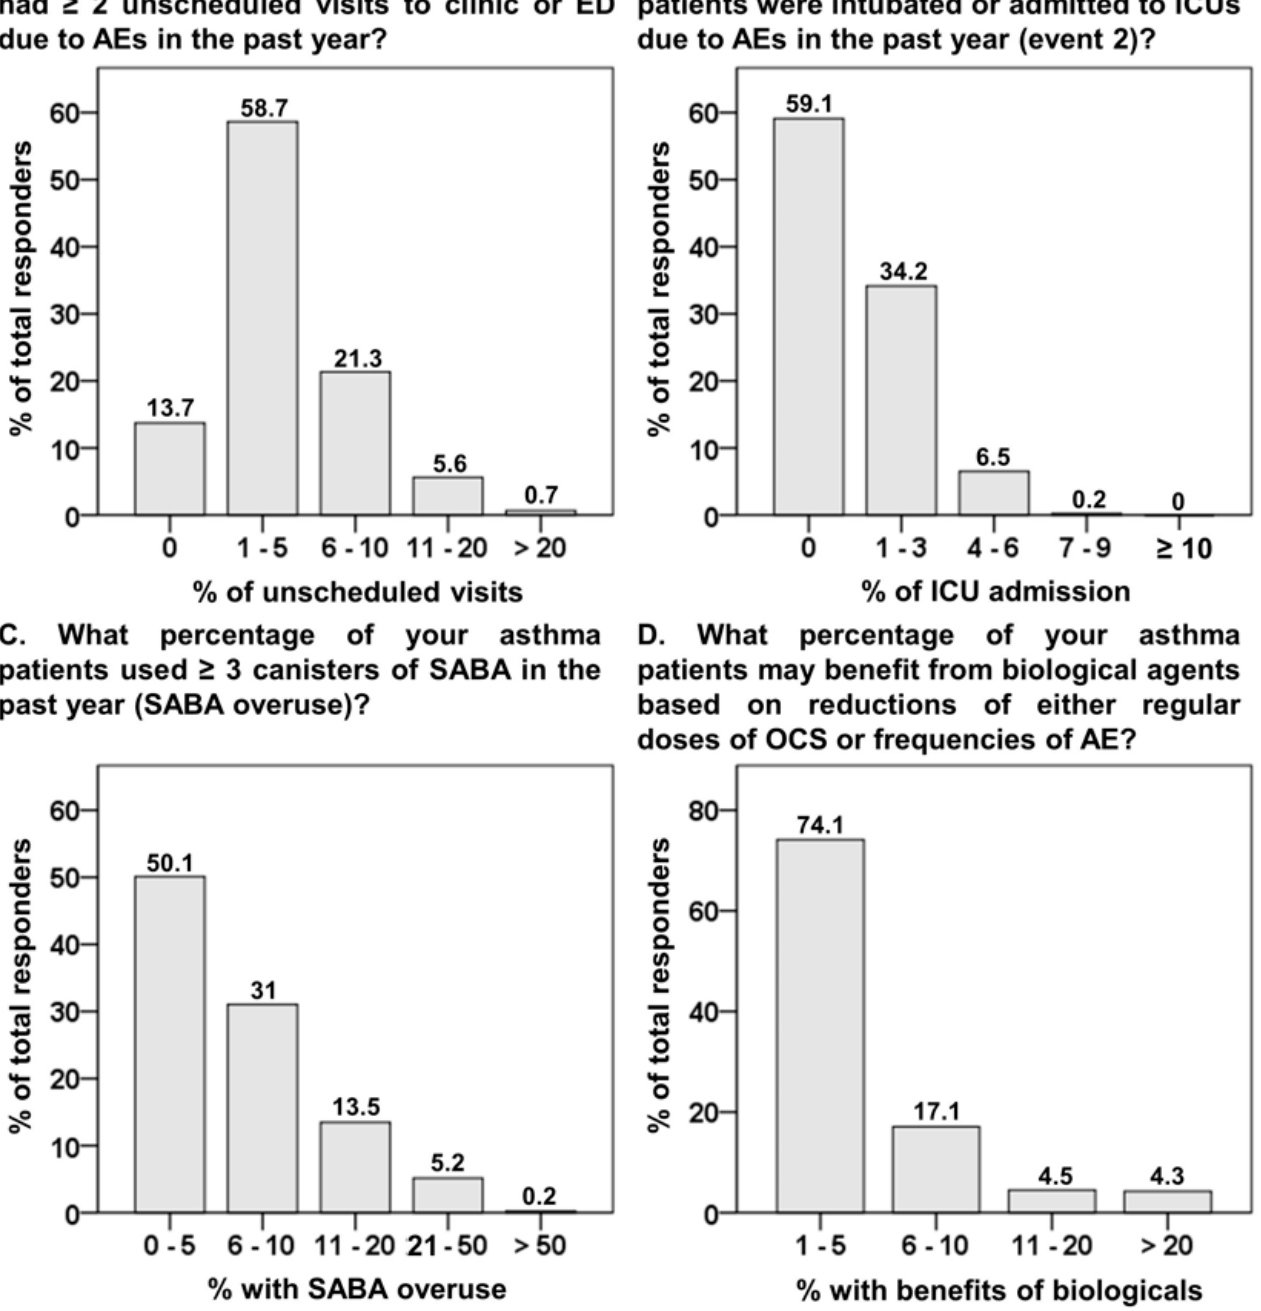
Figure 3. The proportion of responses to questions regarding asthma control status. AE, acute exacerbation; ED, emergent department; ICUs, intensive care units; OCS, oral corticosteroid; SABA, short-acting β 2